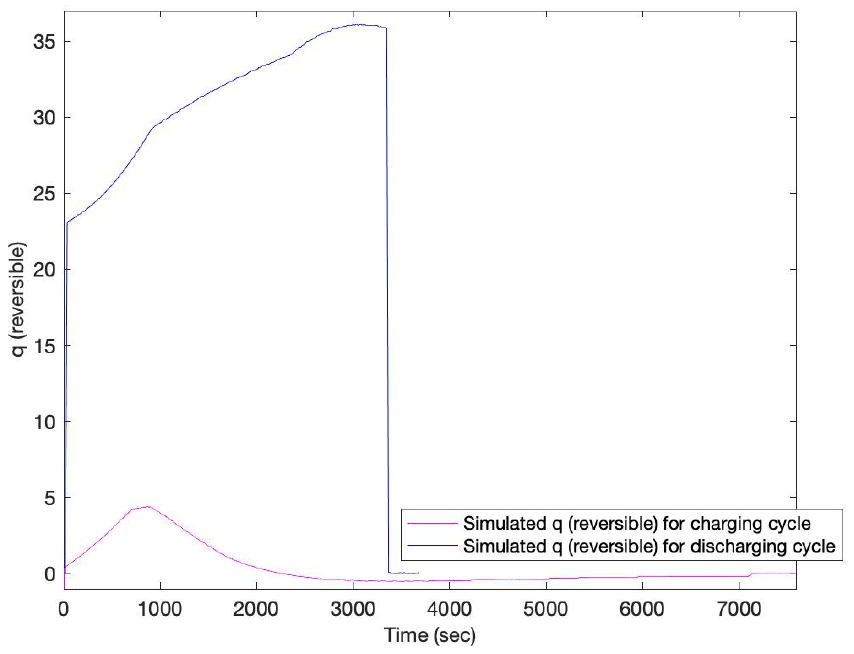
Figure 9. The simulated reversible entropic heating during charging/discharging cycles.